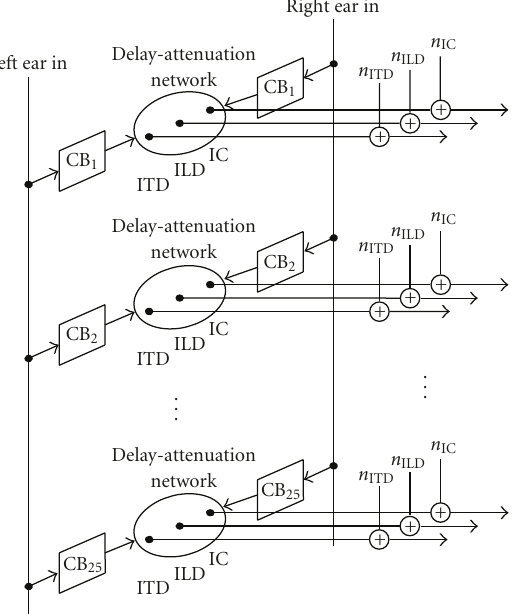
Figure 10: Binaural Cue Physiological Perception Model (BCPPM).